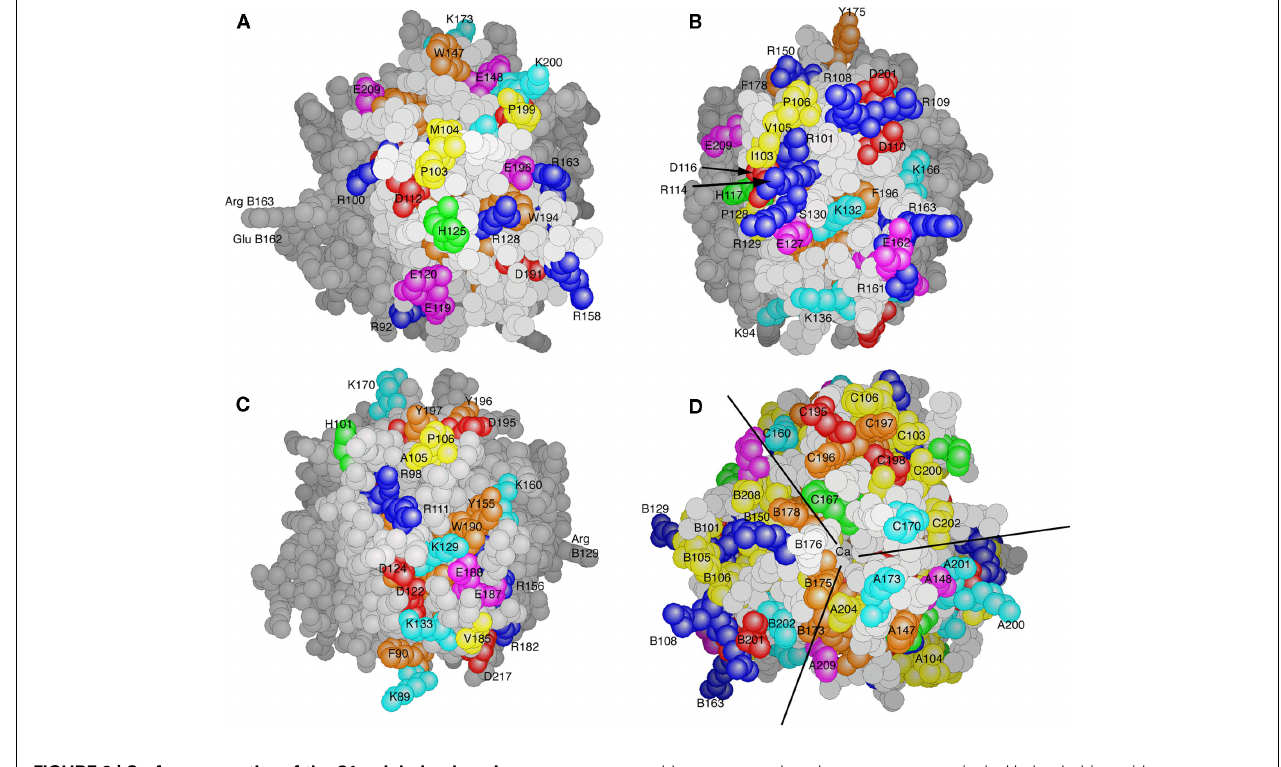
FIGURE 2 | Surface properties of the C1q globular domain. (A–C) Side views of the heterotrimer seen from subunits A, B, and C, respectively. (D) Top view of the heterotrimer.The side chains of Arg, Lys, His, Asp, and Glu residues are shown in deep blue, light